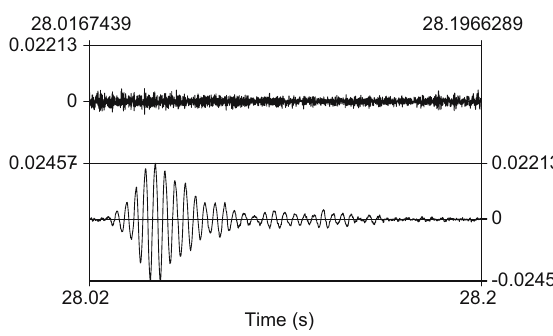
Figure 3: Audible outbreath as a sign of confusion ( line 10, Ex. 5 ) .